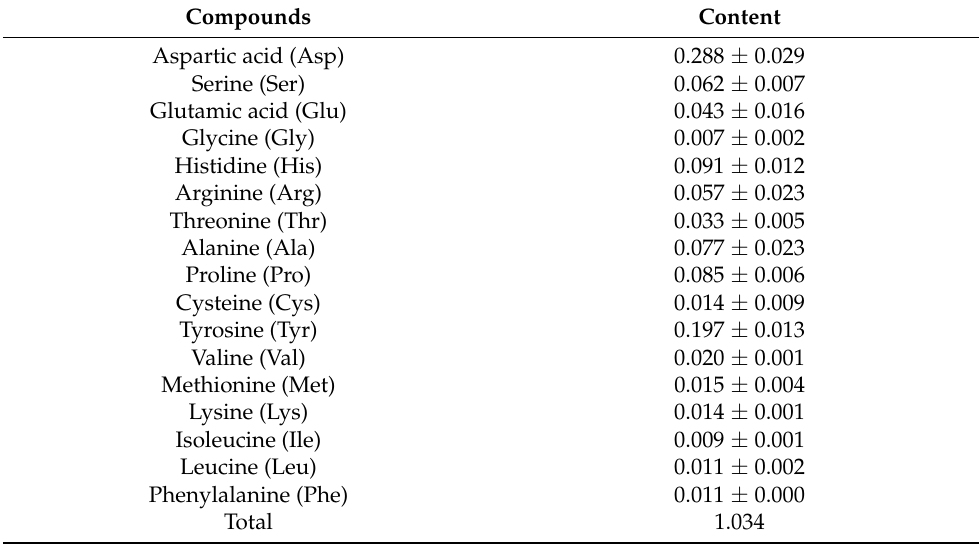
Table 2. Amino acid composition and content of Gonostegia hirta (mg/g DW).